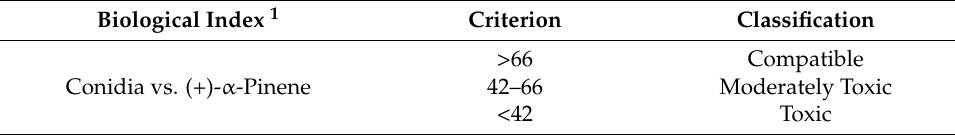
Table 1. Overview of B. bassiana ARSEF 8465 Biological Index